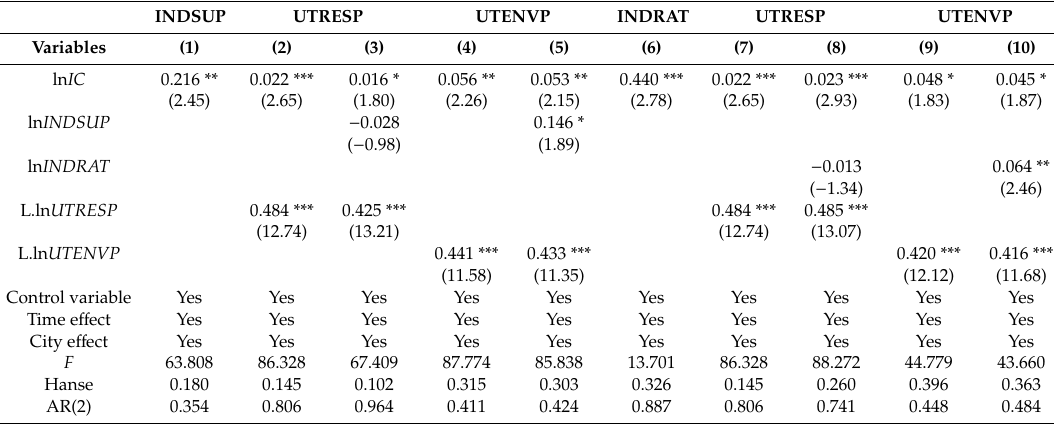
Table 4. Industrial structure restructuring e ff